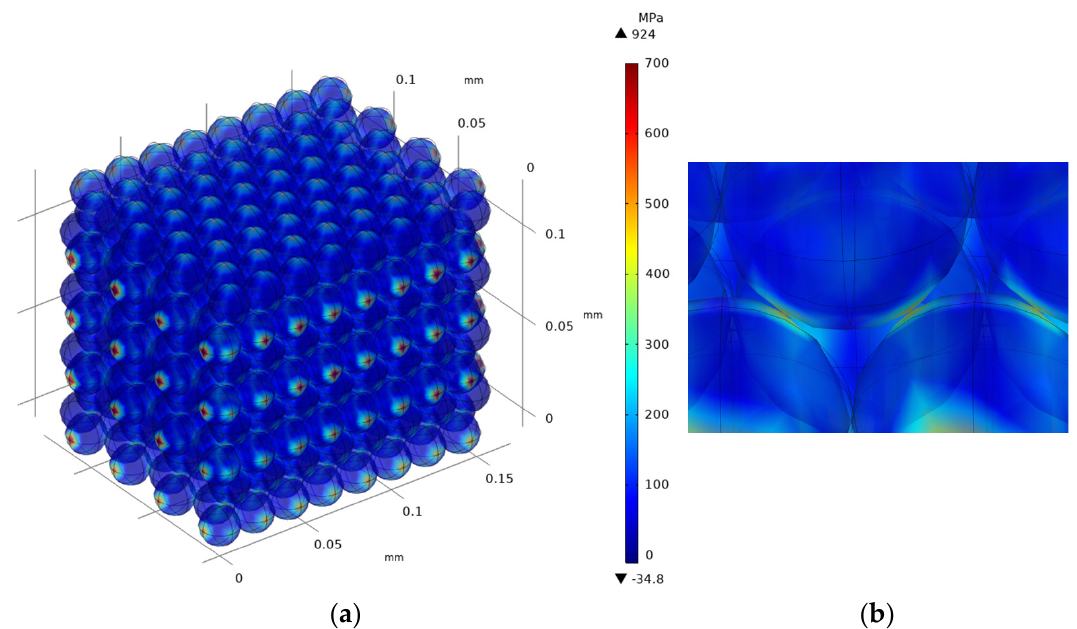
Figure 5. ( a ) Simulation strain diagram of Case 7, ( b ) the detailed diagram shows that the stress at the contact surface is large.